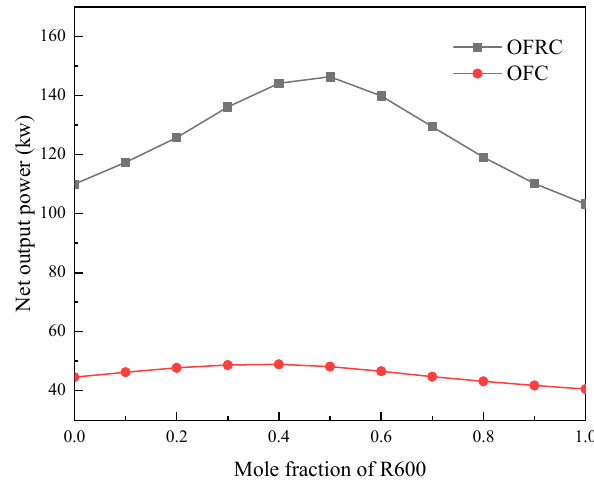
Figure 8. Variation of the net output power with the R600 mole fraction.